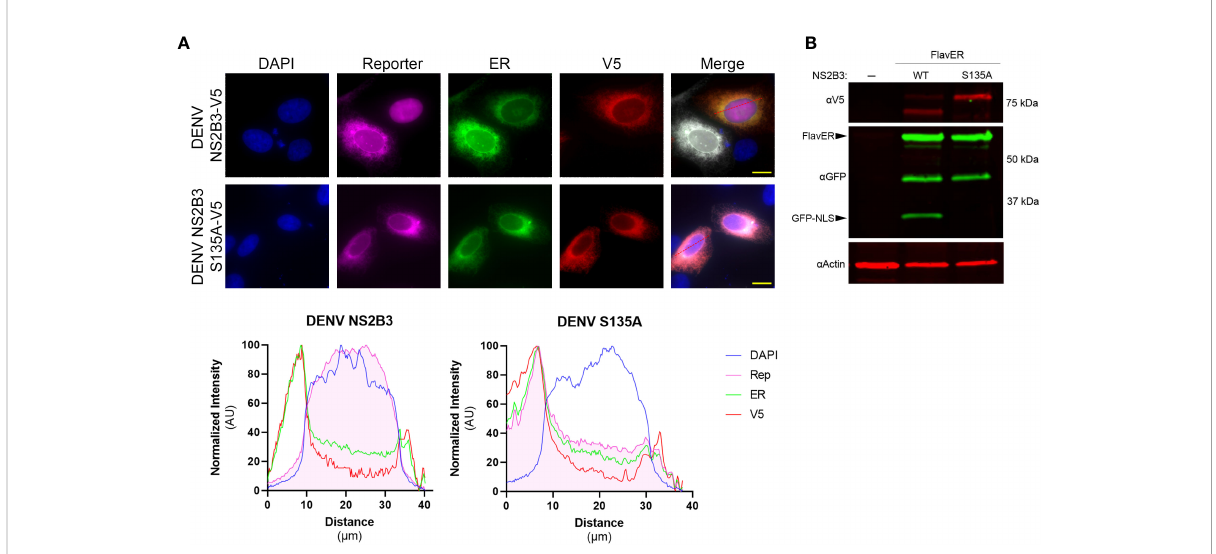
FIGURE 2 FlavER validation with DENV NS2B3. ( A , top panel) Immuno fl uorescence (IF) microscopy of U2OS cells transfected with FlavER and an empty vector or V5-tagged DENV NS2B3. Reporter is shown in magenta, ER marker is shown in green, V5 staining is shown in red, and nuclei are stained with DAPI (blue). Scale bars represent 20 m m. (A, bottom panel) Line plot analyses of normalized signal intensities of DAPI (blue), reporter (magenta), ER (green), and V5 staining (red) for the IF images in the top panel. (B) Immunoblot for V5, GFP, and actin of U2OS cells stably expressing FlavER transfected with an empty vector, active DENV protease, or inactive DENV protease (S135A). Labeled arrows indicate the full- length FlavER construct and the cleaved construct (GFP-NLS). *, denotes an intermediate product due to the non-speci fi c proteolysis of mCherry, which has been previously reported (Huang et al.,